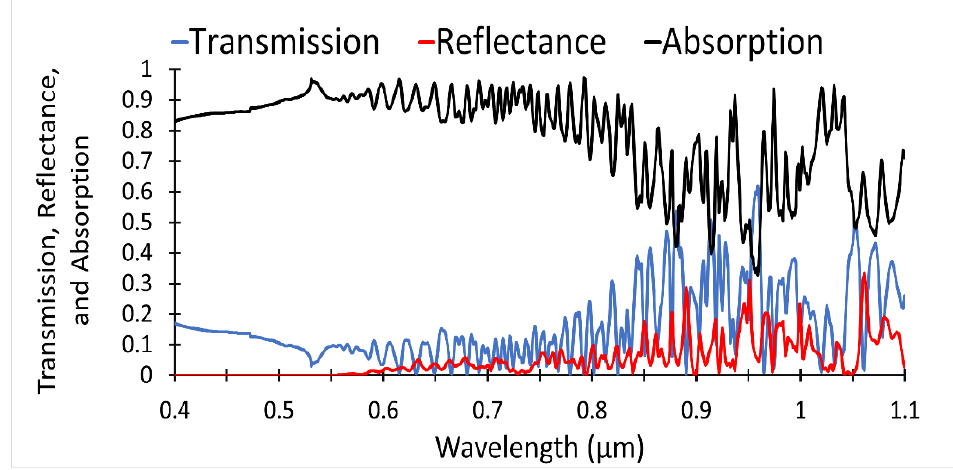
Figure 5. Percentage of absorption, reflectance, and transmission of the SiNWs with a graphene layer on the top of NWs and Au NPs distributed on the silicon substrate.